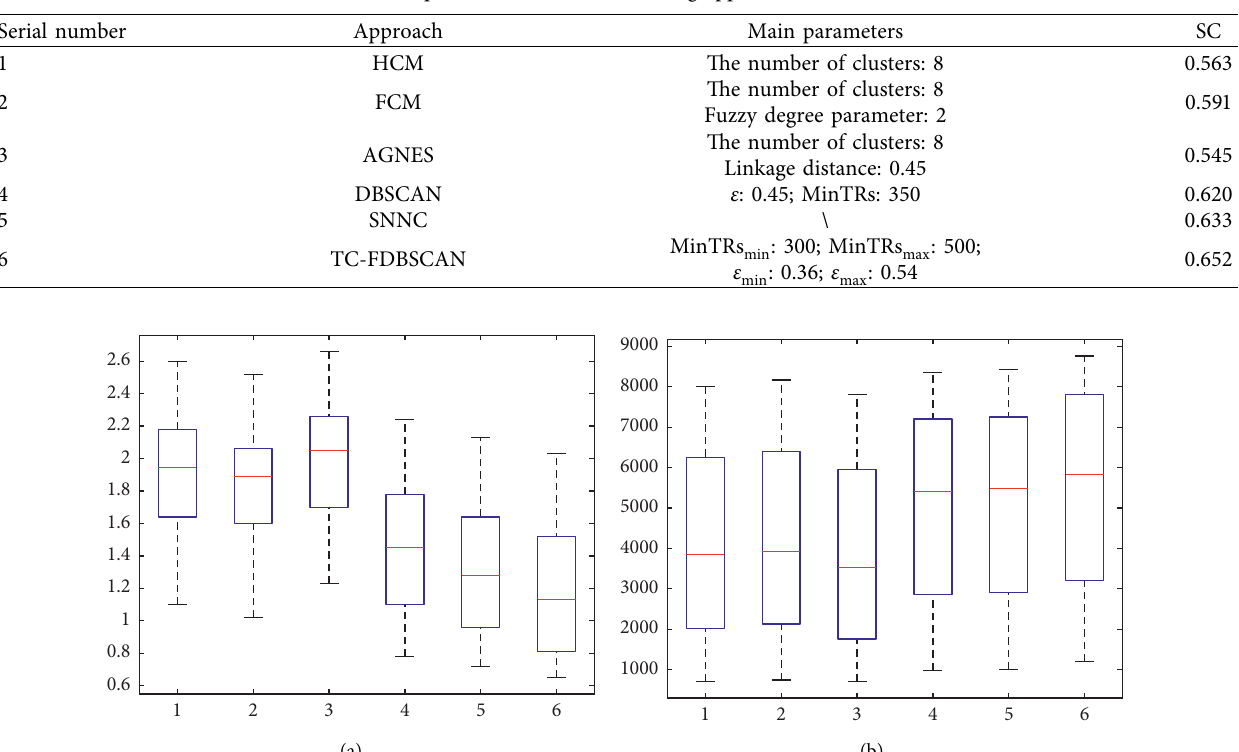
Table 5: Comparison of different clustering approaches for case data.